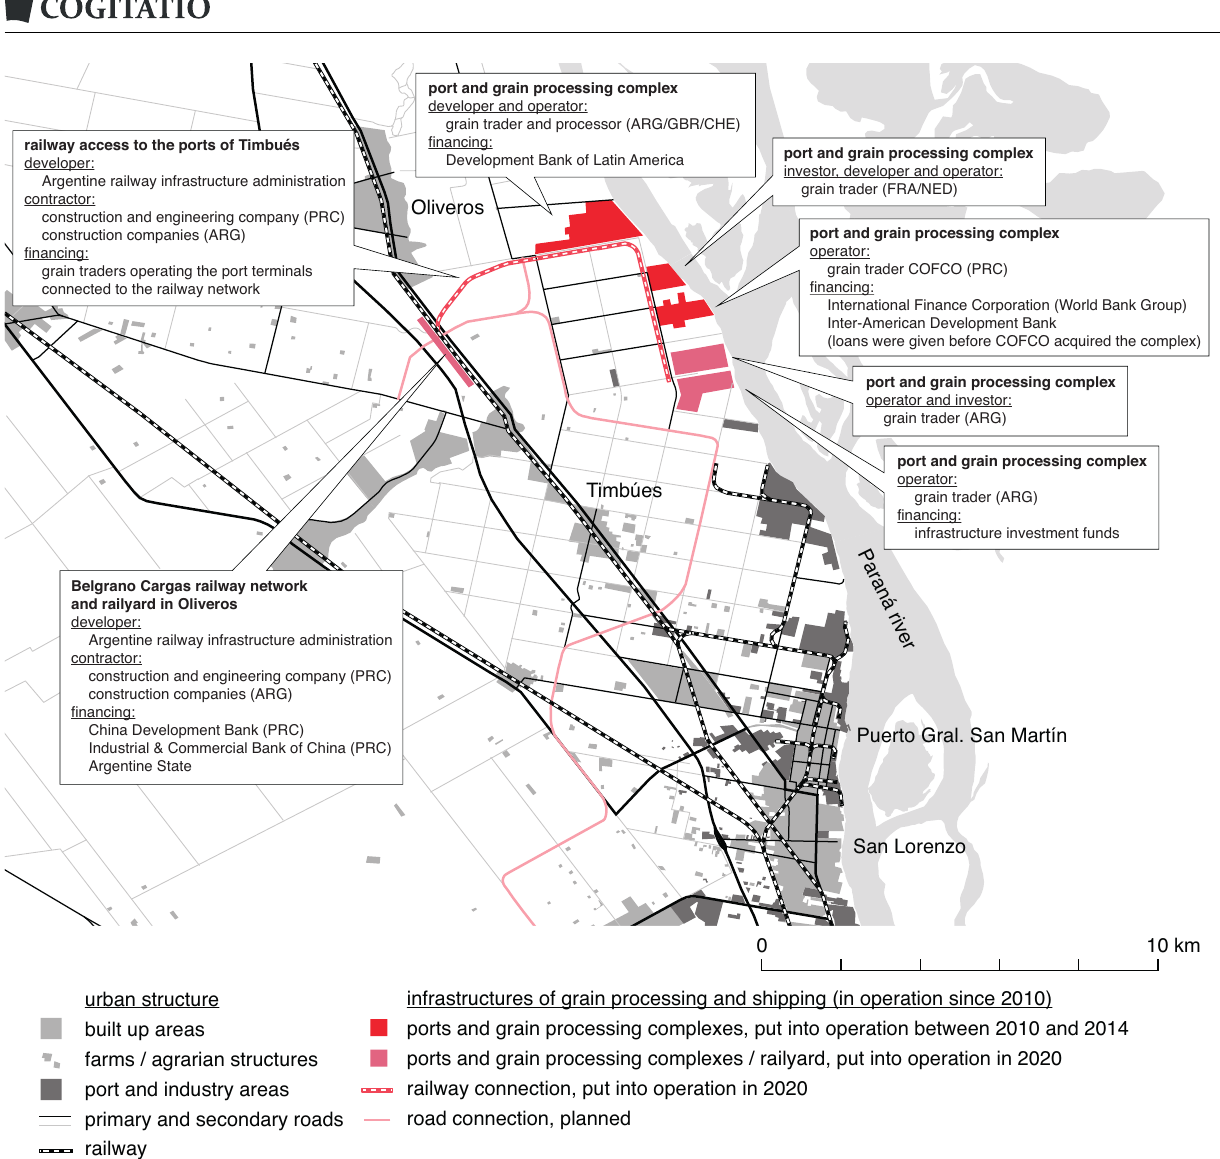
Figure 6. Infrastructure projects for soybean export and their actors around Timbúes, northern Gran Rosario. Sources: Authors based on Google Maps, OpenStreetMap, Calzada et al. (2017), International Finance Corporation (2009), Origlia (2019), Ralev (2013), and Vialidad Nacional